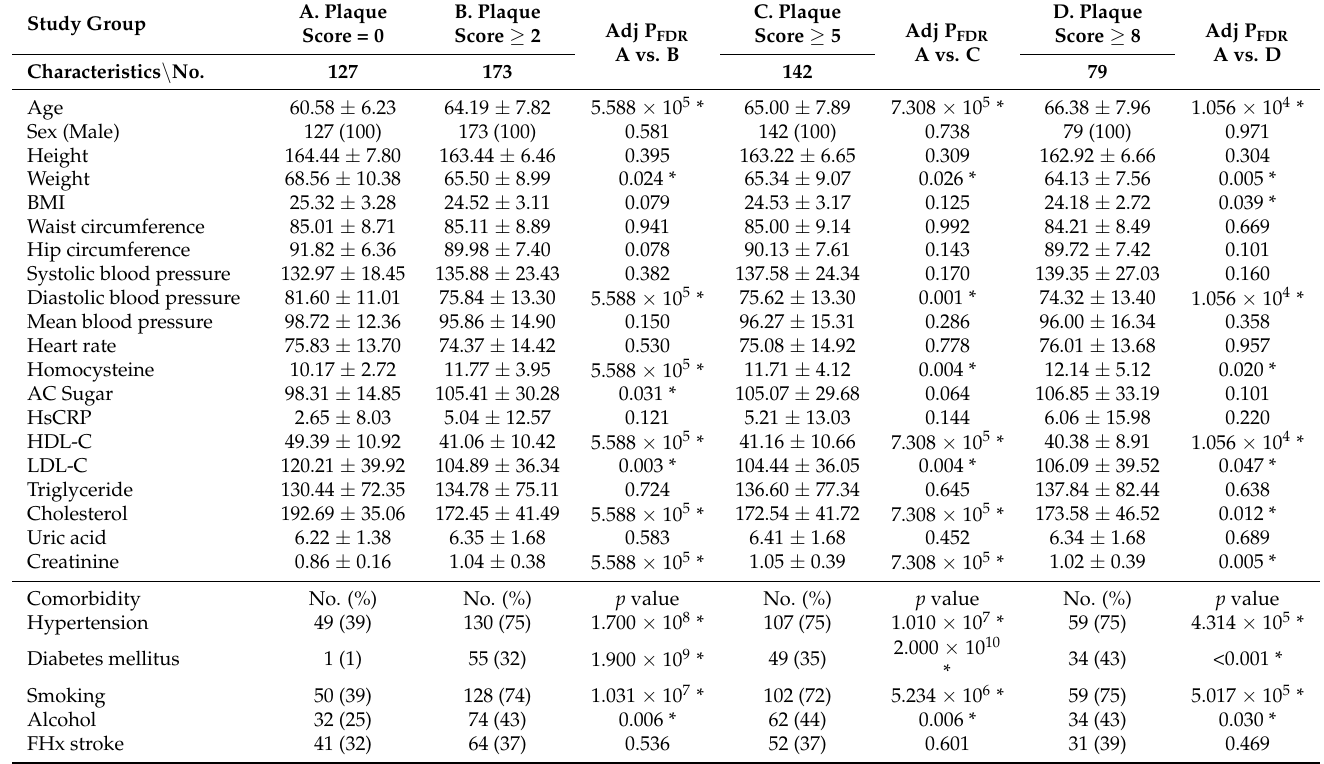
Table 1. Comparison of baseline demographics between normal controls and the 3 subgroups of carotid artery stenosis.